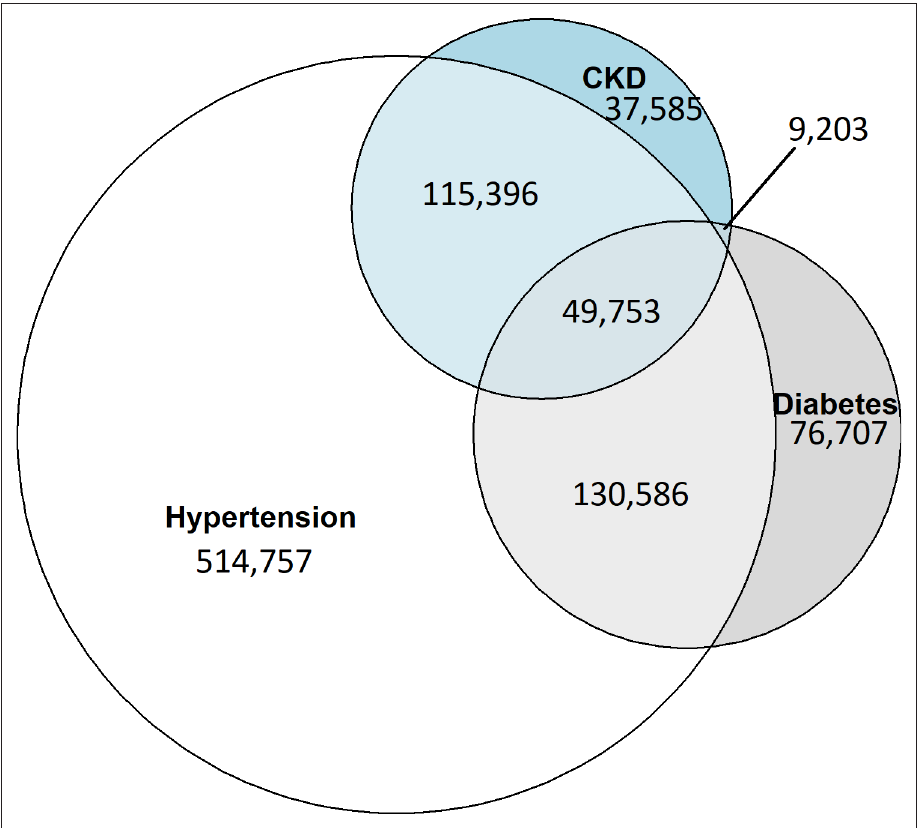
Figure 2 Venn diagram for numbers with each of the three long- term conditions and the overlap between them (933 907 individuals). CKD = chronic kidney